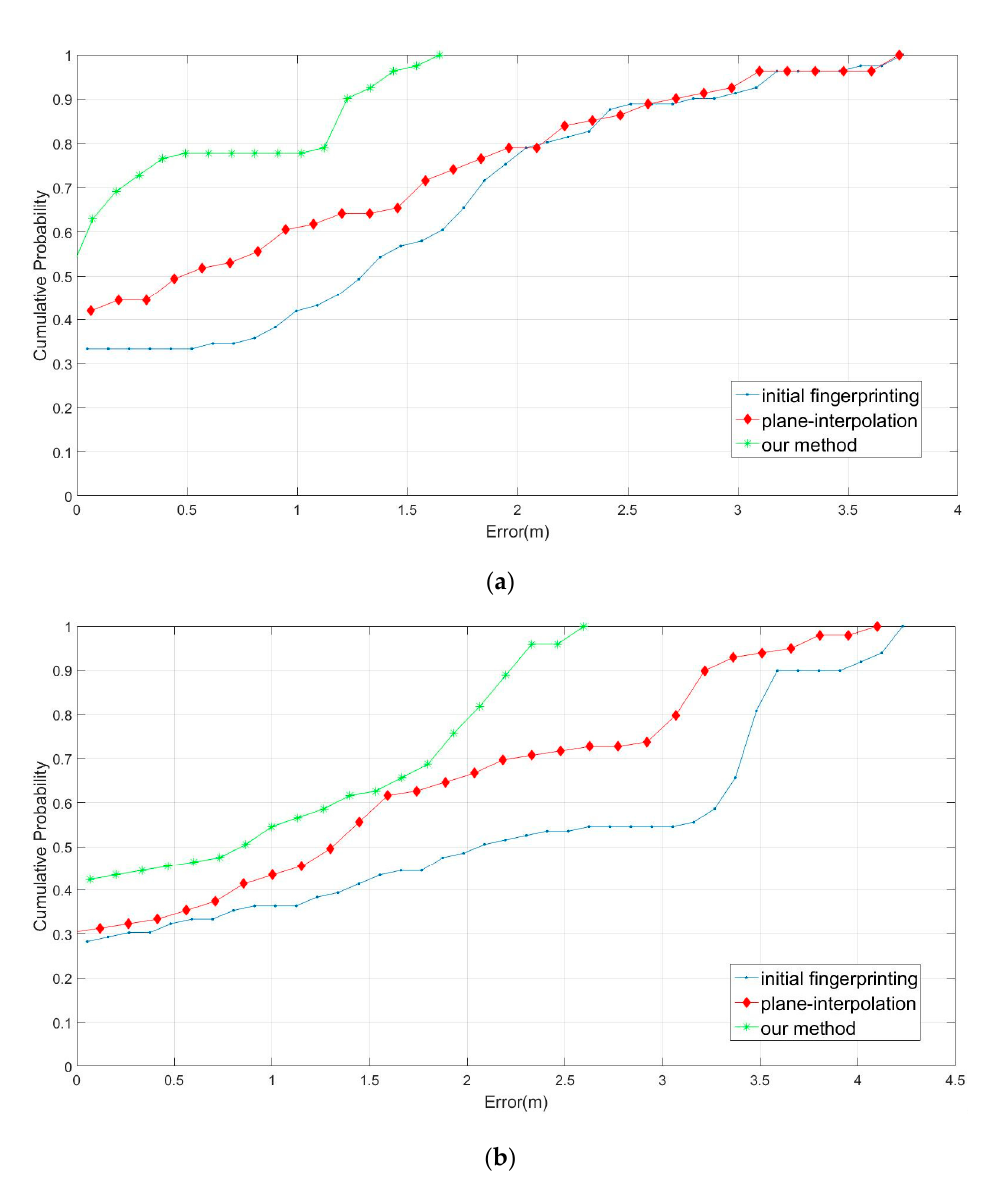
Figure 12. Field experiment ( a ) without and ( b ) with obstacles in the cafeteria.